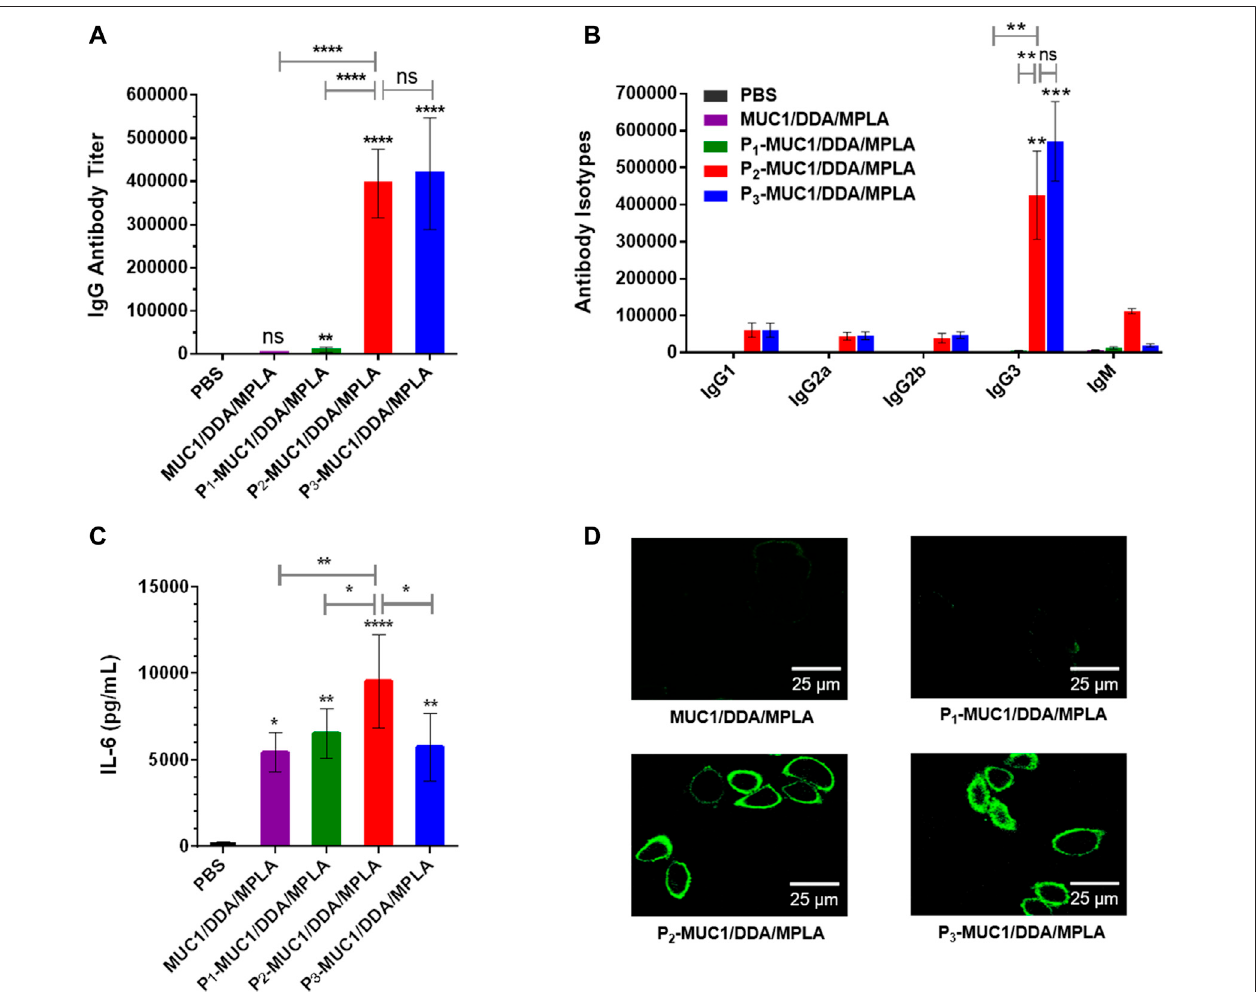
FIGURE6| The secretions ofMUC1-speci fi c IgGantibody (A) , antibody isotypes (B) and cytokines (C) were detected byELISA( n =5). (D) Confocal fl uorescence microscopy images of the cells stained with sera from PBS and the third immunization antisera collected from MUC1/DDA/MPLA, P 1 -MUC1/DDA/MPLA, P 2 -MUC1/ DDA/MPLA, P 3 -MUC1/DDA/MPLA. The images are representative of fi ve independent experiments (Scale bar = 25 μ m).